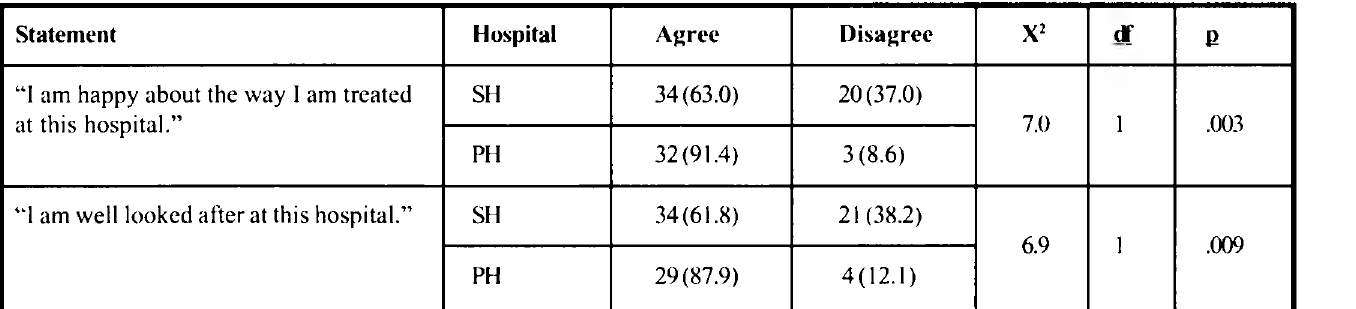
Table 5: TB hospital patients’ satisfaction with care